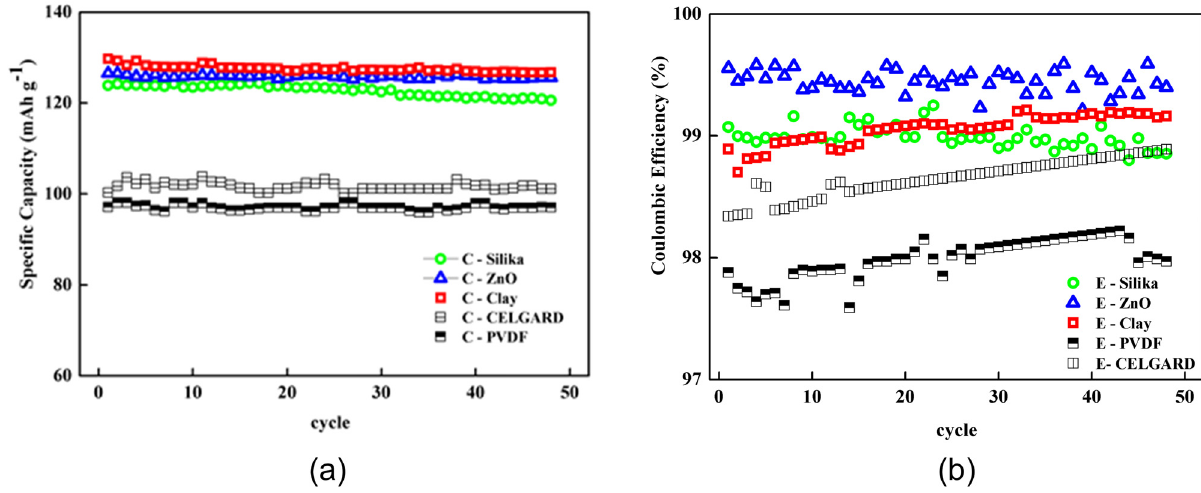
Figure 4: ( a ) Speci fi c capacity and ( b ) Coulombic e ffi ciency of LiFePO4/GPE/graphite full cells at a charge – discharge rate 0.2 C ( 0.4 mA )